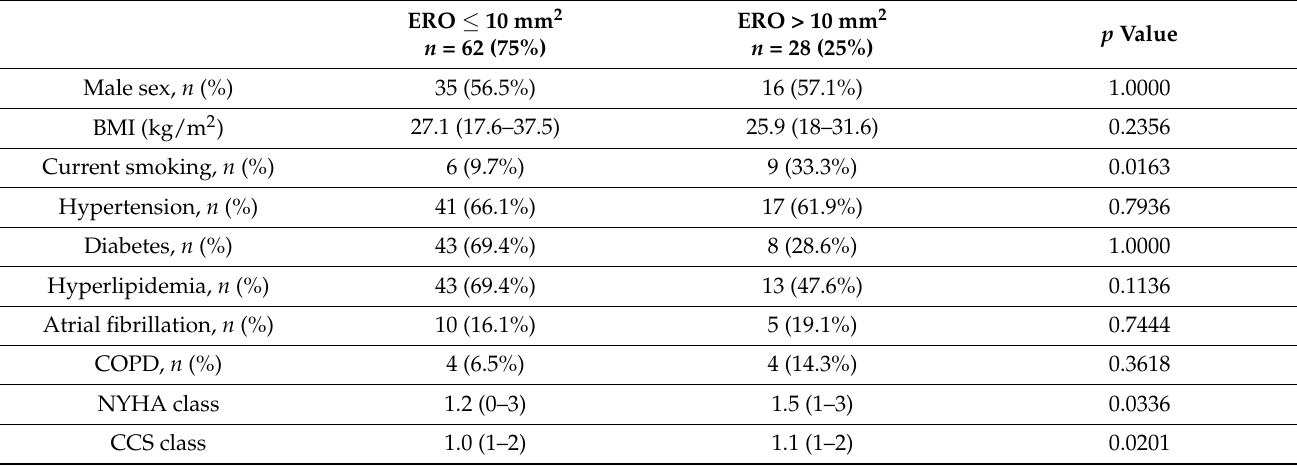
Table 6. Comparison of patients in CABGa group with IMR with ERO ≤ 10 mm 2 and ERO > 10 mm 2 in 1 year